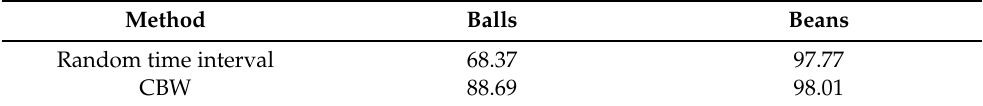
Figure 10. Correct classification rate for both datasets using the contrast-based time windowing with different time window lengths. In this case, the HATS approach with a SVM is used for classification. Table 1. Comparison between the classification accuracy in percent using a random time interval and CBW of the same length using HATS with a SVM as classifier.